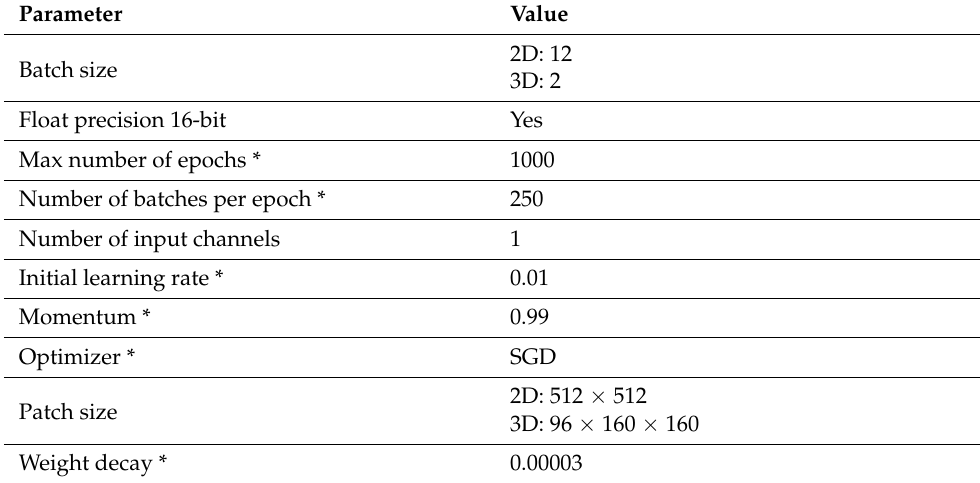
Table 2. Key parameters of the nnU-Net framework. SGD-stochastic gradient